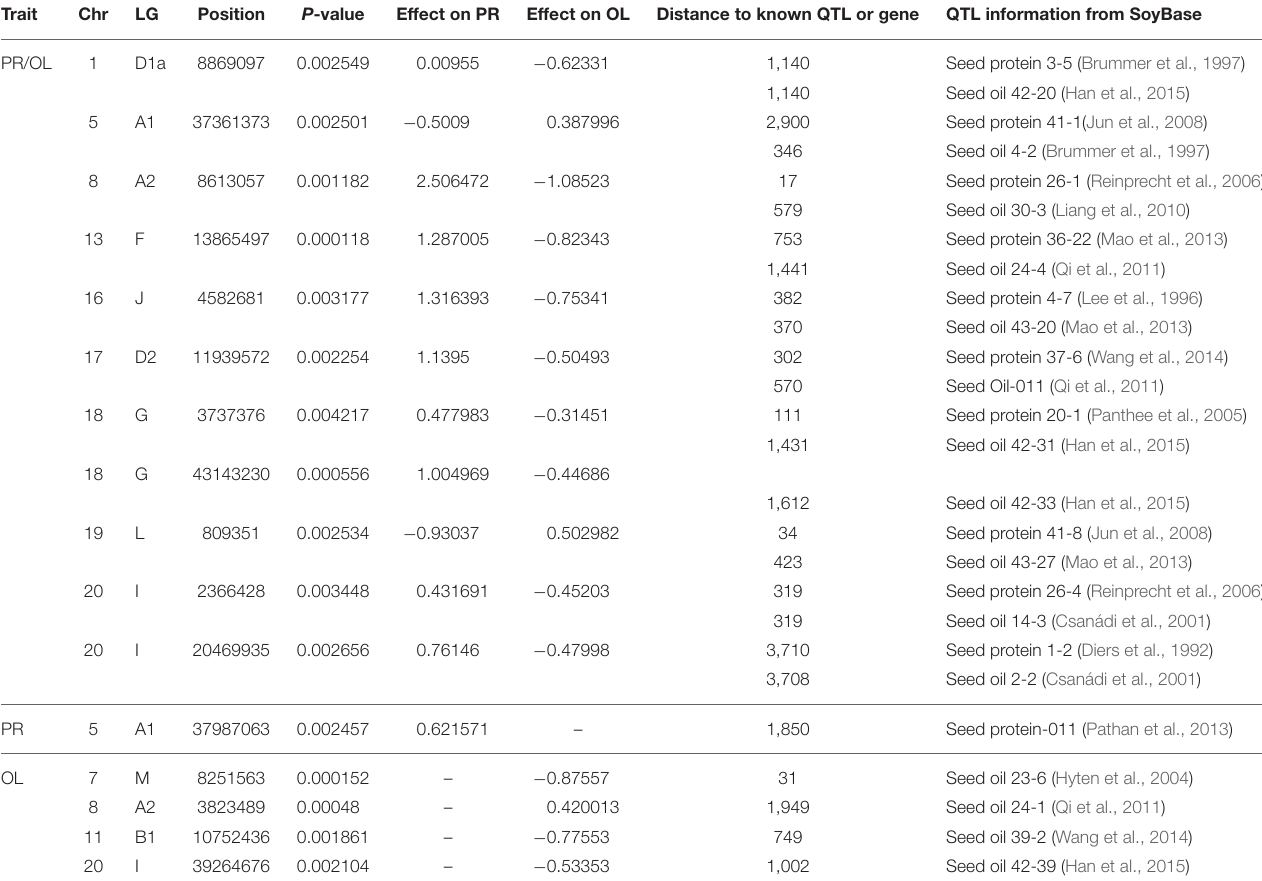
TABLE 7 | Physical position, P- value, effect, and distance to known QTL or known genes of QTN for protein and oil content (PR/OL), oil content only (OL) and protein content only (PR) using FarmCPU. Trait Chr LG Position P -value Effect on PR Effect on OL Distance to known QTL or gene QTL information from